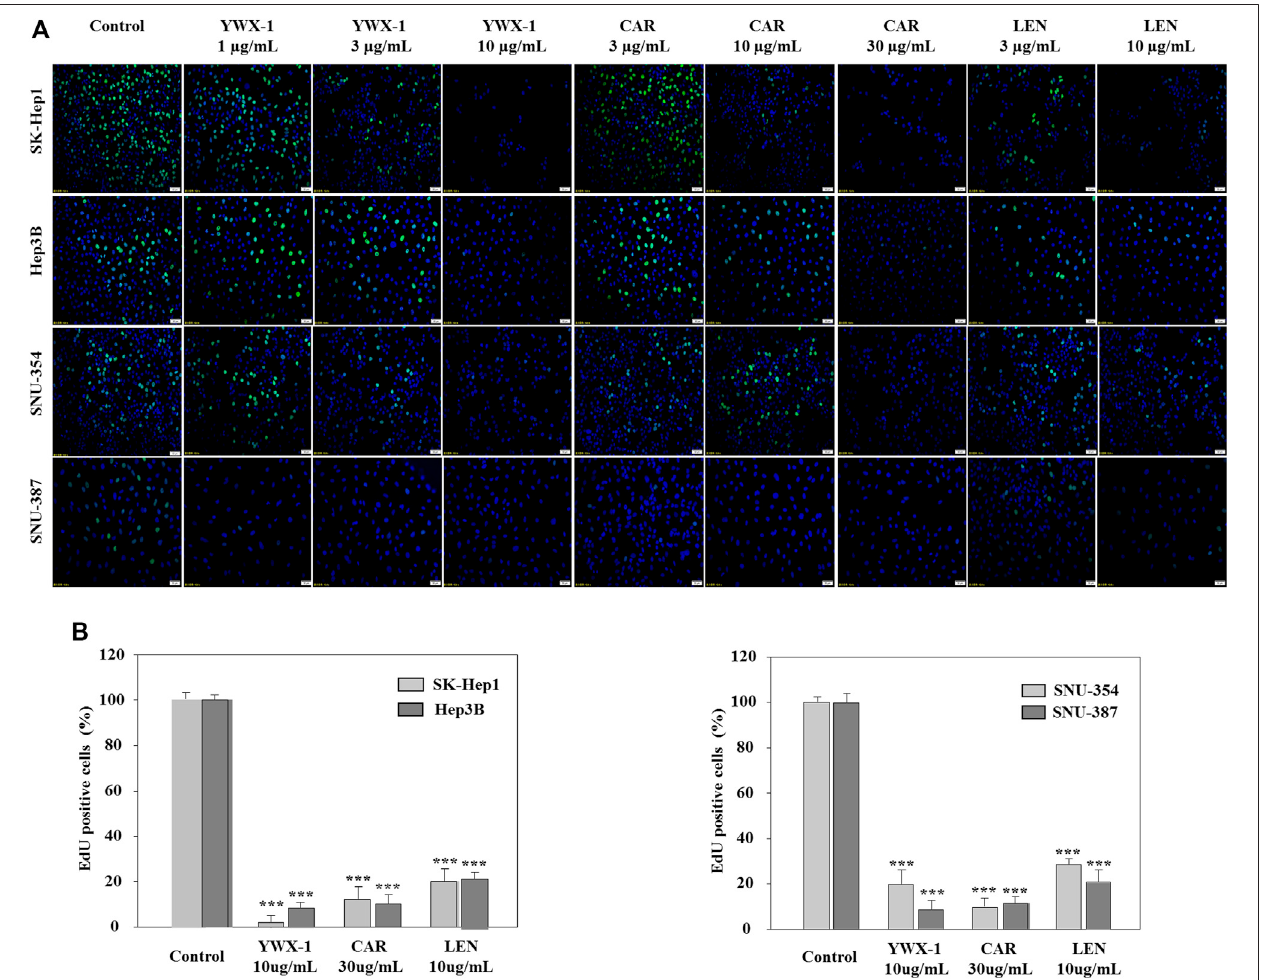
FIGURE 3 | Carrimycin (CAR) and monomeric isovalerylspiramycin I (YWX-1) inhibit DNA replication in hepatocellular carcinoma cells. (A) SK-Hep1, Hep3B, SNU- 354, and SNU-387 cells were treated with different concentrations of carrimycin and monomeric isovalerylspiramycin I. Cell proliferation was measured by EdU assays. The EdU-labeled replicating cells were examined under a fl uorescence microscope (scale bar, 50 μ m). (B) Statistically signi fi cant differences are indicated when compared with control group. Data represented as mean ± standard deviation of three independent experiments (n (cid:2) 3).